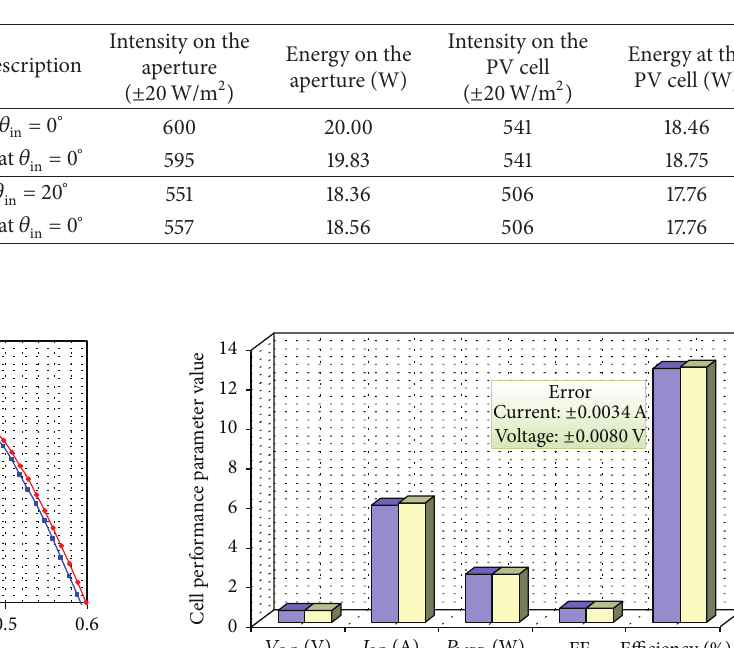
Table 3: Incident irradiance and energy flux at the aperture and on the surface of a PV cell for the CPC and V-trough collector for the two experimental test conditions.